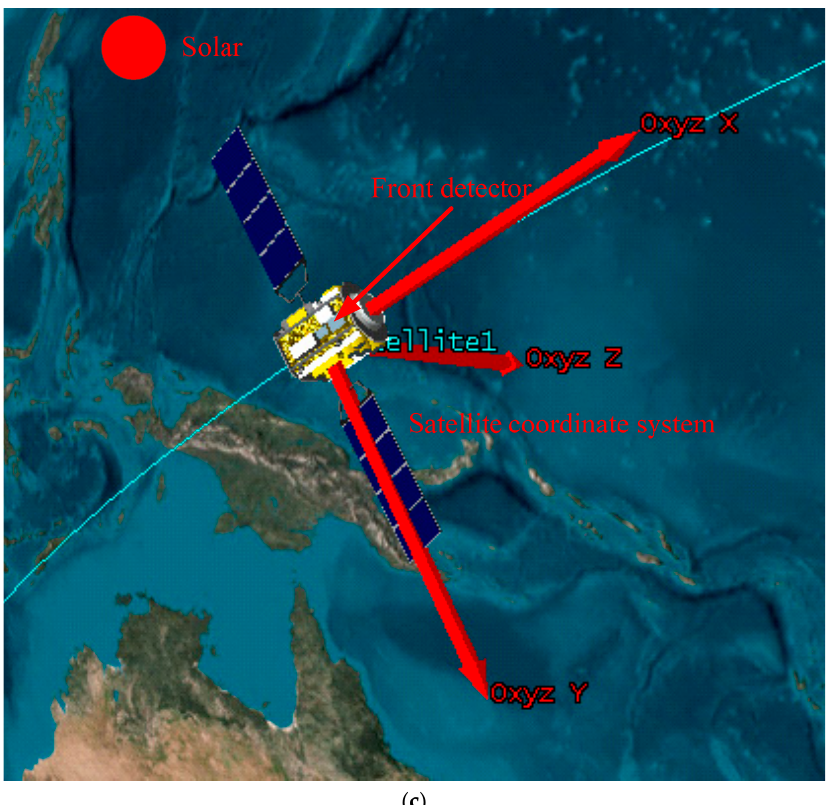
Figure 1. ( a ) The components of the spectrometer and the coordinate systems. ( b ) Orbit diagram. ( c ) The position of front detection on satellite.